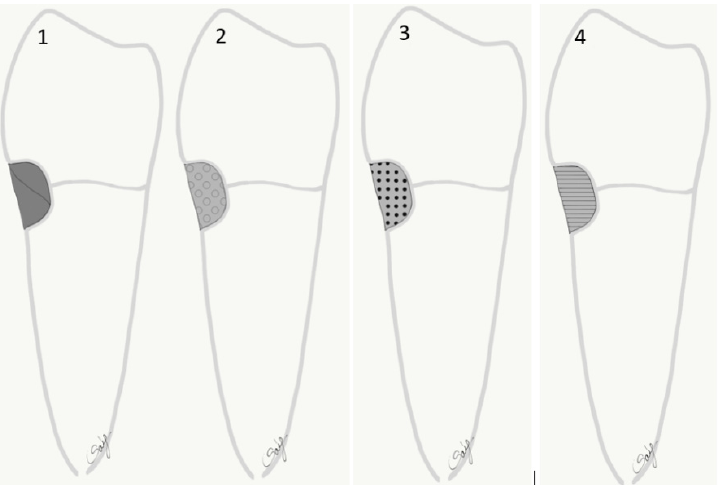
Figure 1. Diagram showing the test groups restored with different direct filling materials. 1: packable composite PC; 2: high flowable composite HF; 3: low flowable composite LF; 4: resin modified glass ionomer cement RMGIC. Group 1: The teeth were restored with packable (PC) resin composite (Essentia Univer- sal, GC Europe). The resin composite was applied in two consecutive oblique increments. Each layer was light-cured for 20